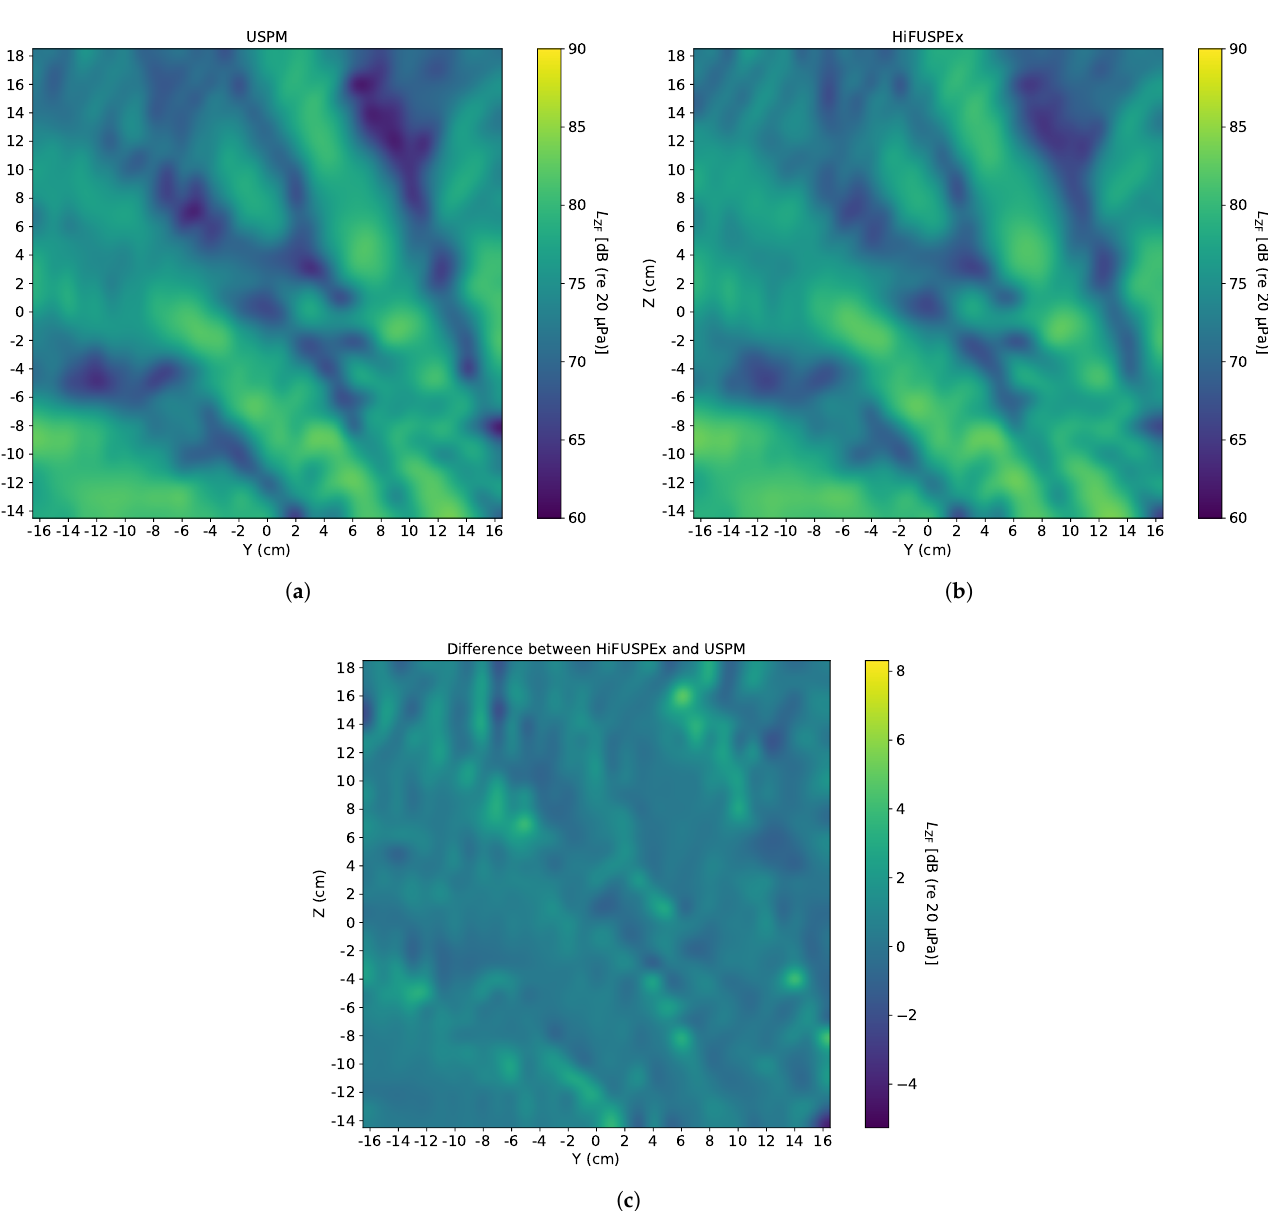
Figure 11. Sound fields within the scanning unit when an idealized signal of a welding machine (10 kHz) was simulated. Results were obtained on the right-hand side with the artificial head in the sedentary position and without the protection grid mounted. The presented plots show the sound fields obtained for: ( a ) USPM; ( b ) HiFUSPEx; and ( c ) difference between the HiFUSPEx and the USPM. Please refer to Figure 10 for identification of zy